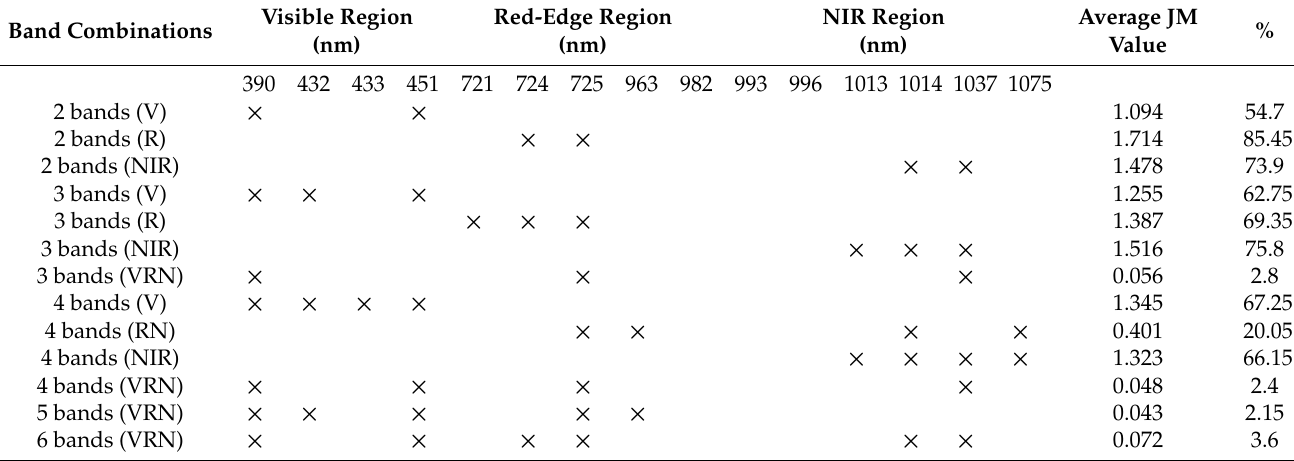
Table 7. The averages of JM distance analysis for all pairs of plant species (55). The symbol ( × ) indicates the selection of optimal bands in each band